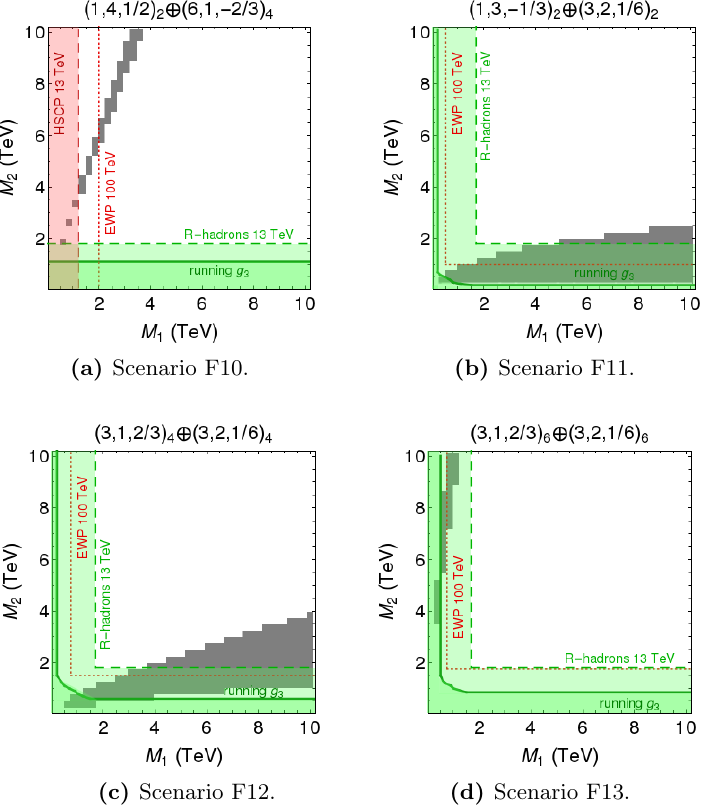
Figure 4. The same as (cid:12)gure 3 but for scenarios